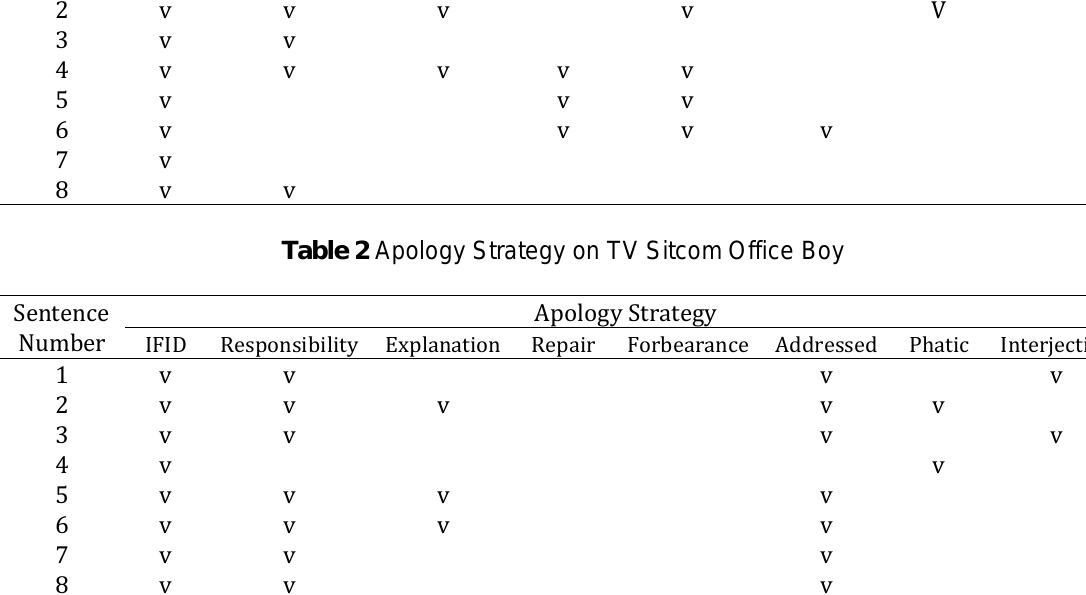
Table 1 and Table 2 Apology Strategy on TV Sitcom Friends and Office Boy